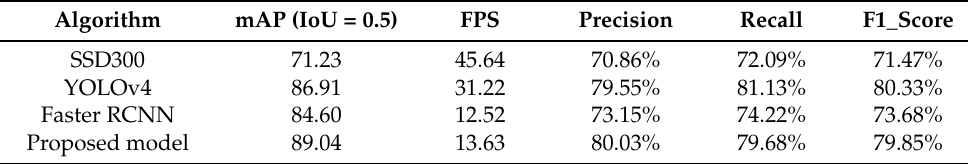
Table 3. Comparison results of the proposed method and state-of-the-art